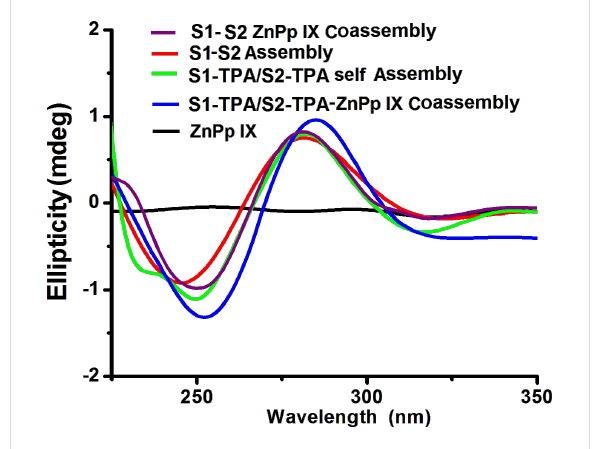
Figure 7: CD spectra showing the chirality and conformation of nanofiber (S1 DNA–TPA/S2 DNA–TPA triconjugate Zn PpIX coassembly) and their